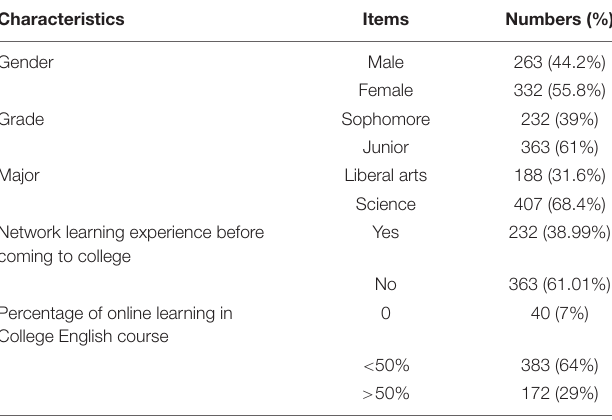
TABLE 1 | Demographic information of participants.